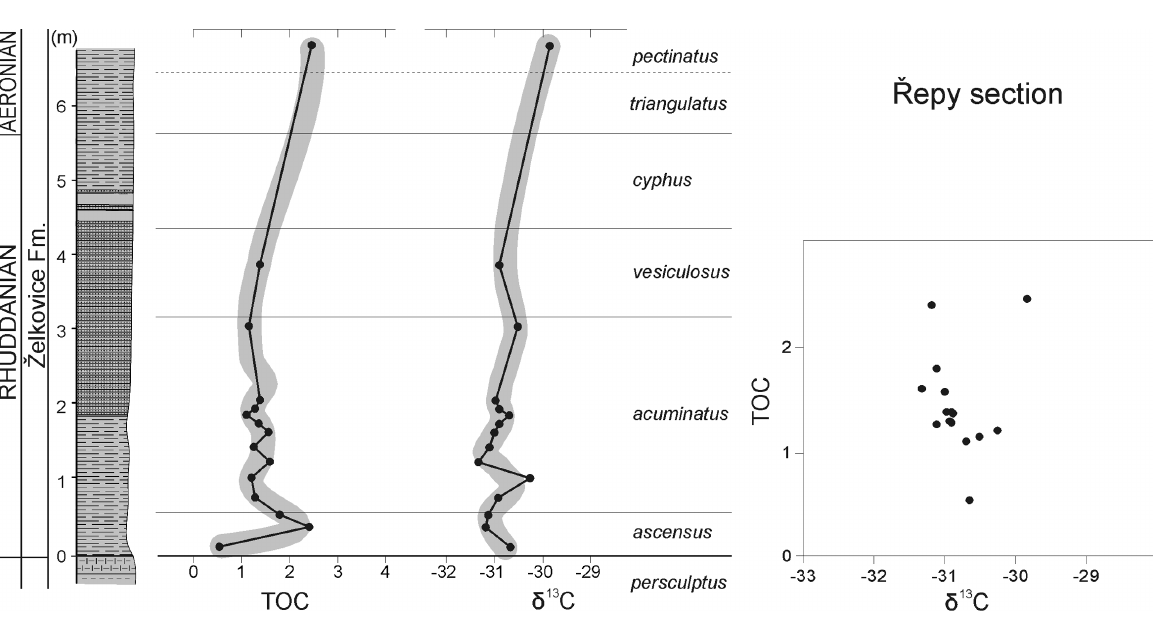
Fig. 3. The δ 13 C org record across the Ř epy section of the (cid:142)elkovice Formation (Barrandian area; northern peri-Gondwana) and relationship of δ 13 C org ((cid:137) VPDB) and TOC (%) values. The grey line represents locfit regression. See Fig. 2 for legend.